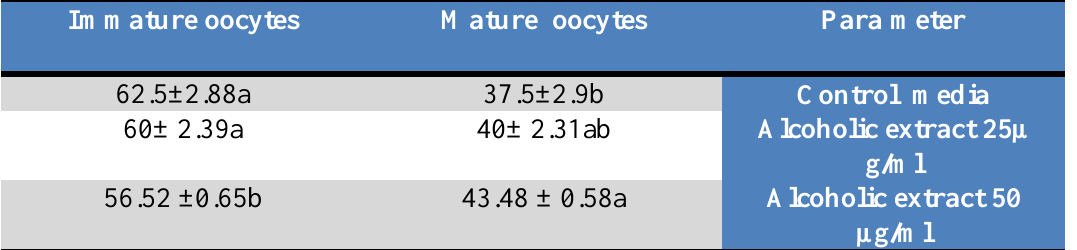
Table 2: The effect of alcoholic extract of tribulus terrestris on the maturation percentage of large follicles (6-10mm).